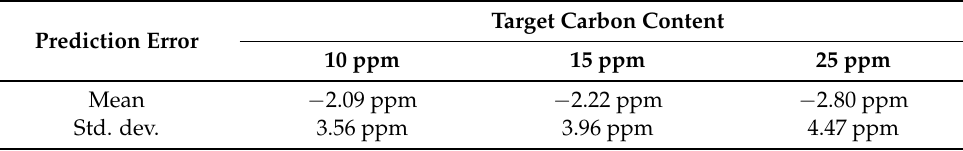
Figure 7. Predictive performance of endpoint carbon concentrations on test data. ( a ) Target vs. predicted values of the ANN model (blue line: regression line with slope 0.478; black line: ideal prediction line with slope 1.0; gray lines: the predicted values are within the ideal line ± 5 ppm); ( b ) error distribution for all test data; ( c ) error distribution by the period of collected data; ( d ) box plot of prediction error by target values (filled circles represent the mean values of each steel type). Table 2. Prediction error of the ANN model according to the target carbon